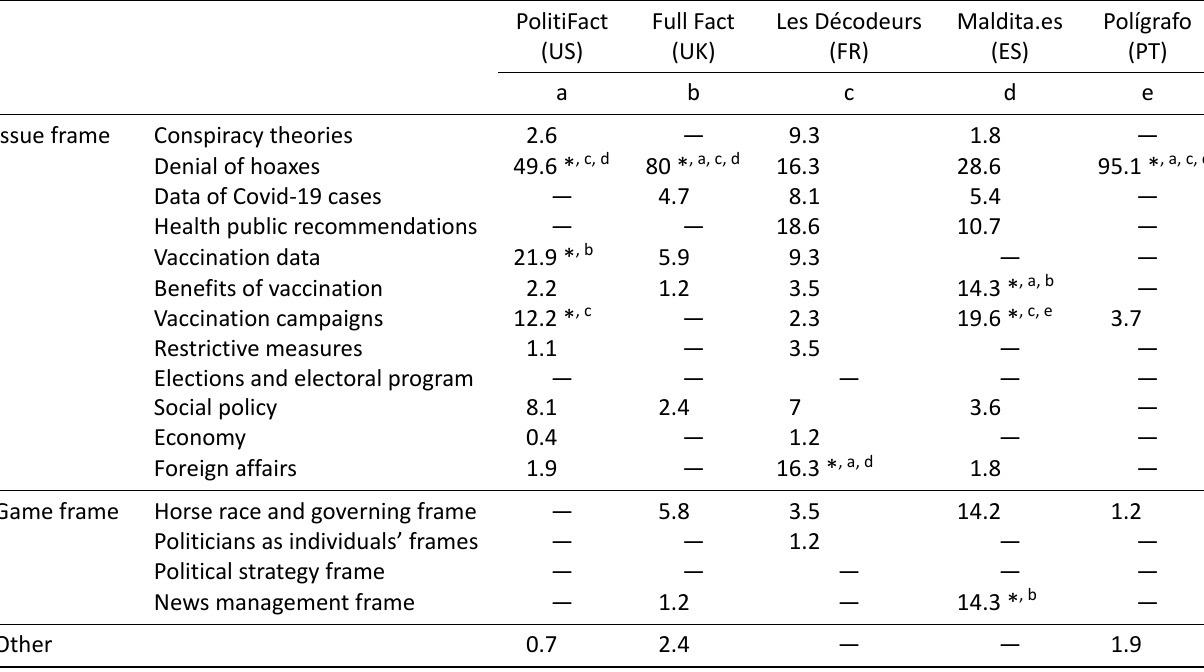
Table 5. Issues and strategies in the tweets of the fact‐checking projects